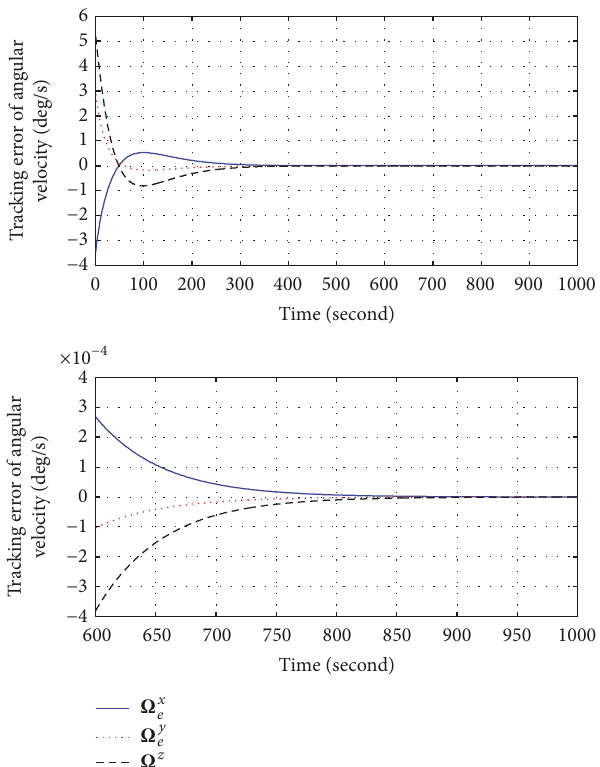
Figure 4: Tracking error of the angular velocity of